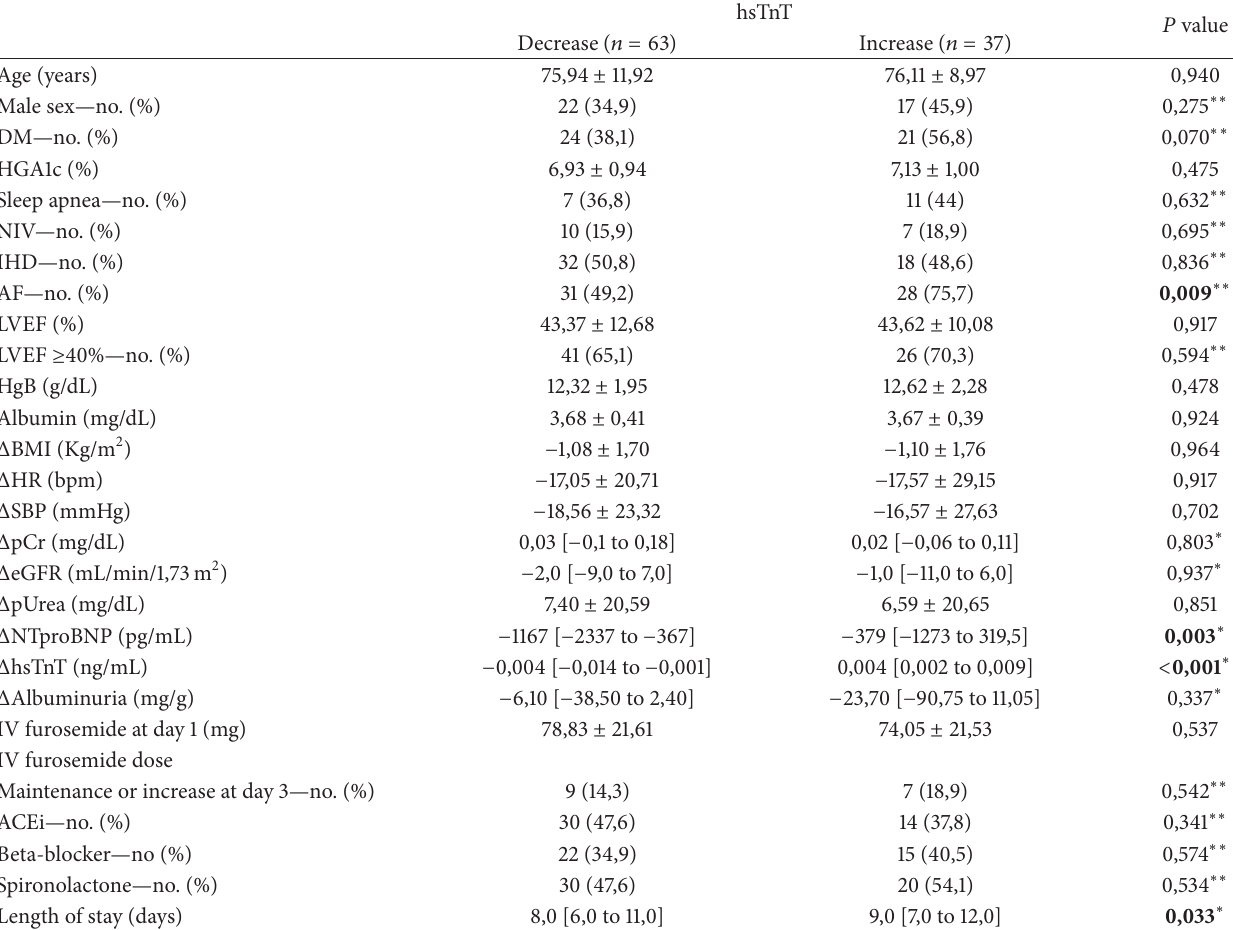
Table 5: Determinants of hsTnT dichotomic